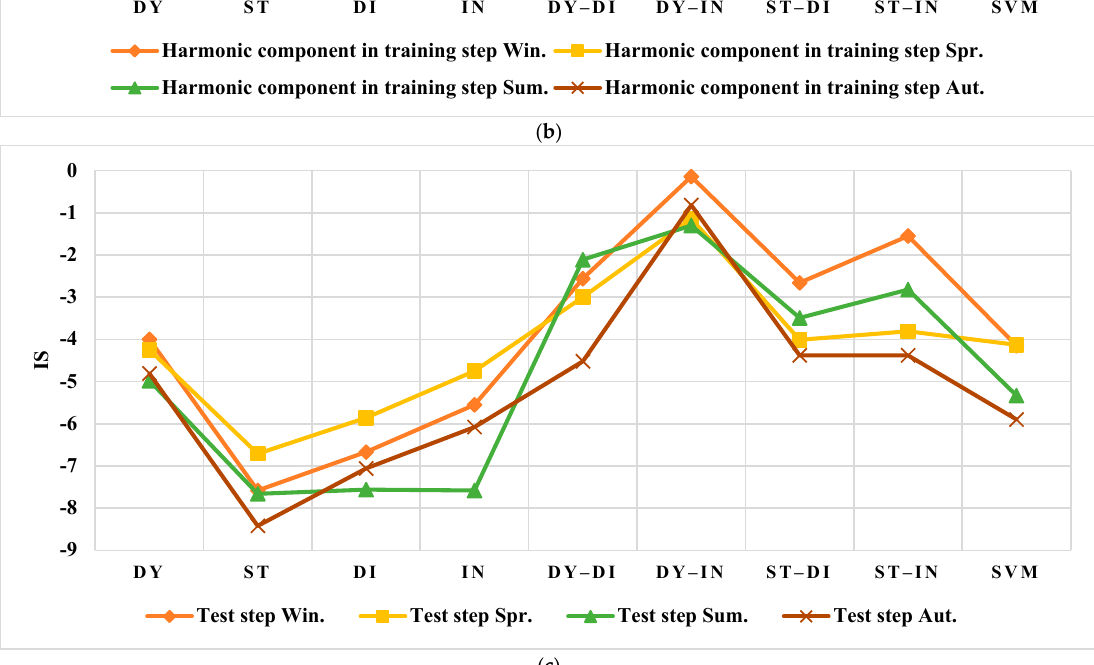
Figure 21. The results of average IS for the US: ( a ) Main Component in training step, ( b ) Harmonic Component in training step, ( c ) Test step